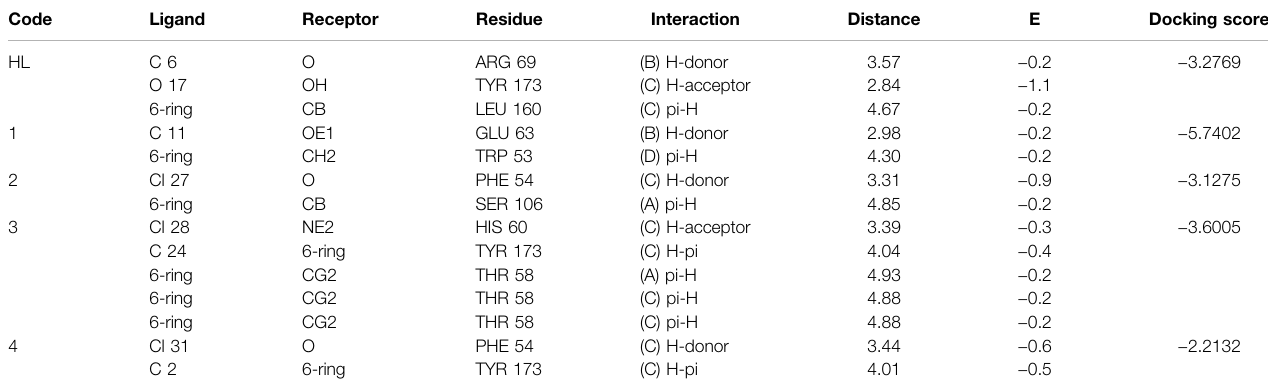
TABLE 5 | Ligand acid ( HL ) and complexes 1 – 4 interaction report with nucleocapsid protein.